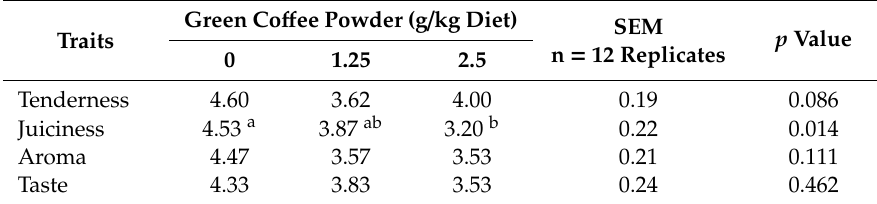
Table 7. E ff ect of green co ff ee powder on sensory characteristics of chicken